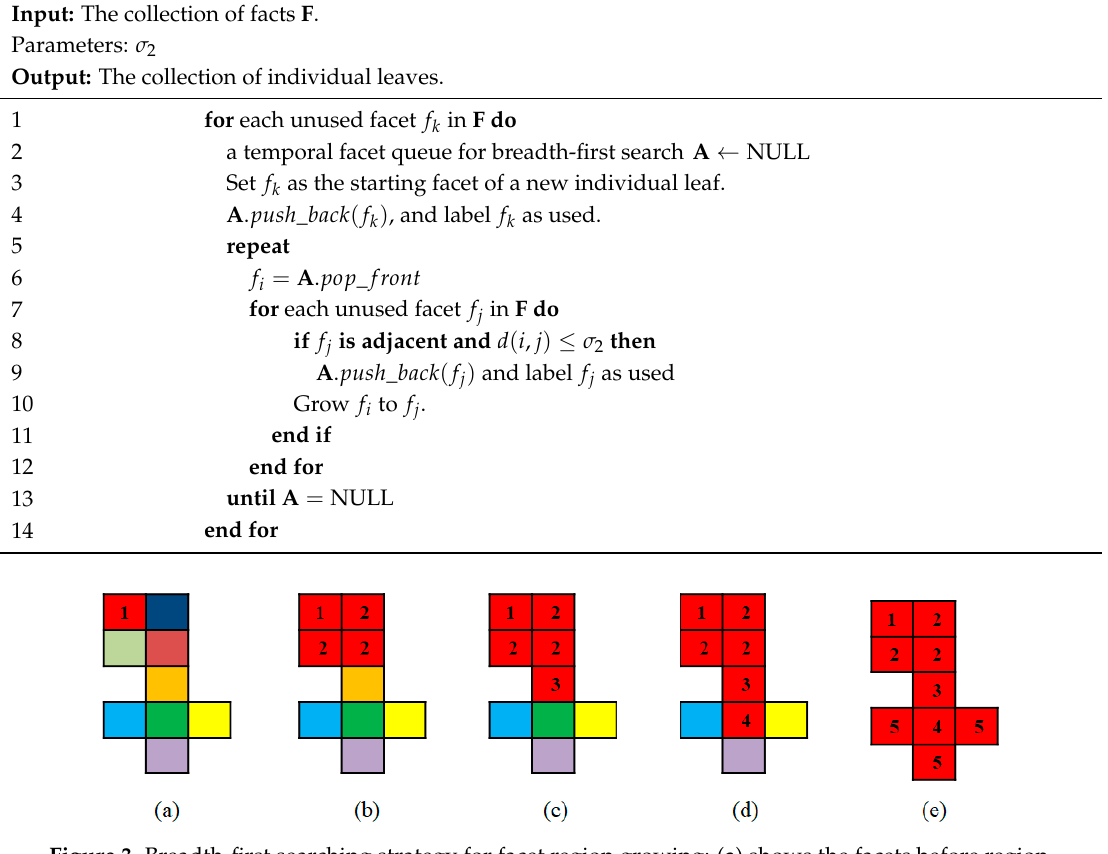
Figure 3. Breadth-first searching strategy for facet region growing: ( a ) shows the facets before region growing started; ( b ) shows the result of the first round of facet region growing; ( c ) shows the result of the second round of facet region growing; ( d ) shows the result of the third round of facet region growing; ( e ) shows the result of the final round of facet region growing.3. Results and Discussion.